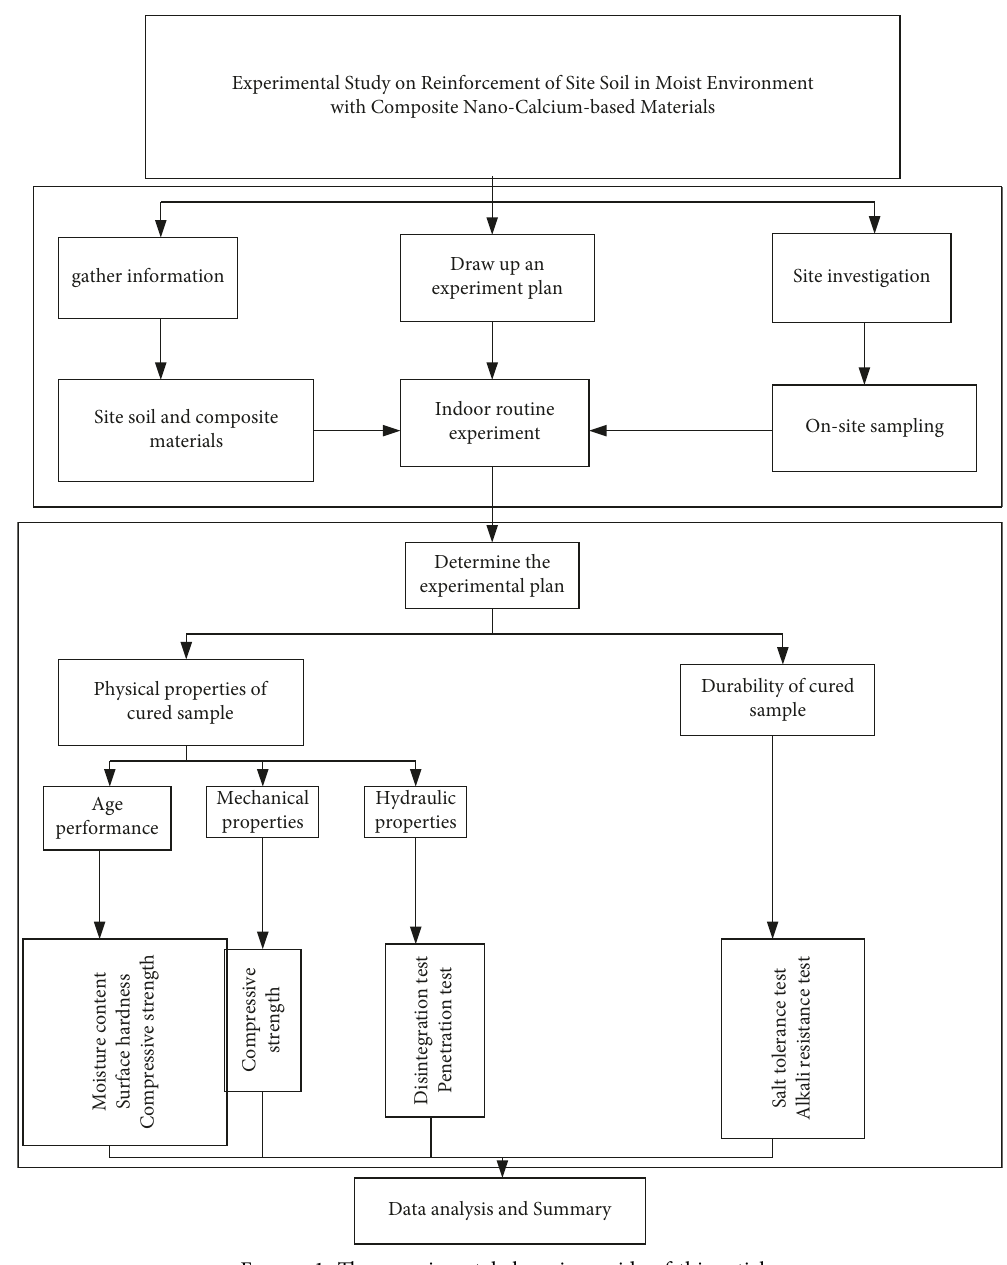
Figure 1: The experimental shopping guide of this